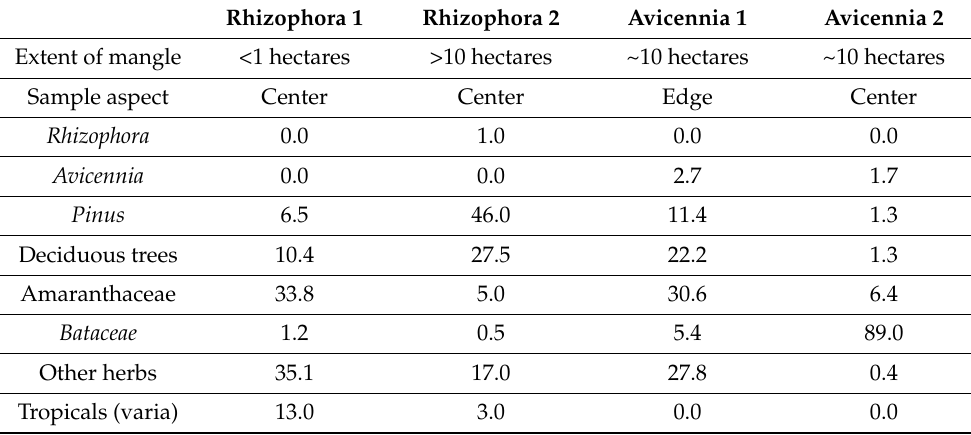
Table 9. Summary pollen percentages at mangrove analog